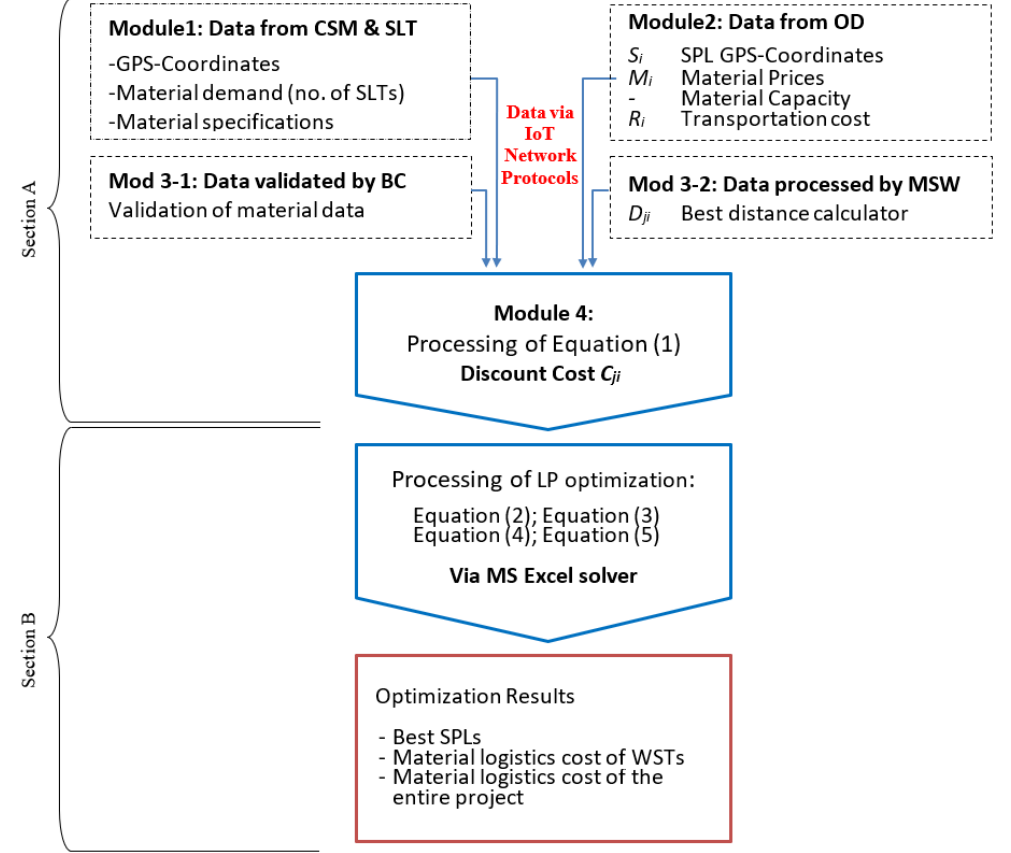
Figure 1. The flowchart of the proposed smart framework.